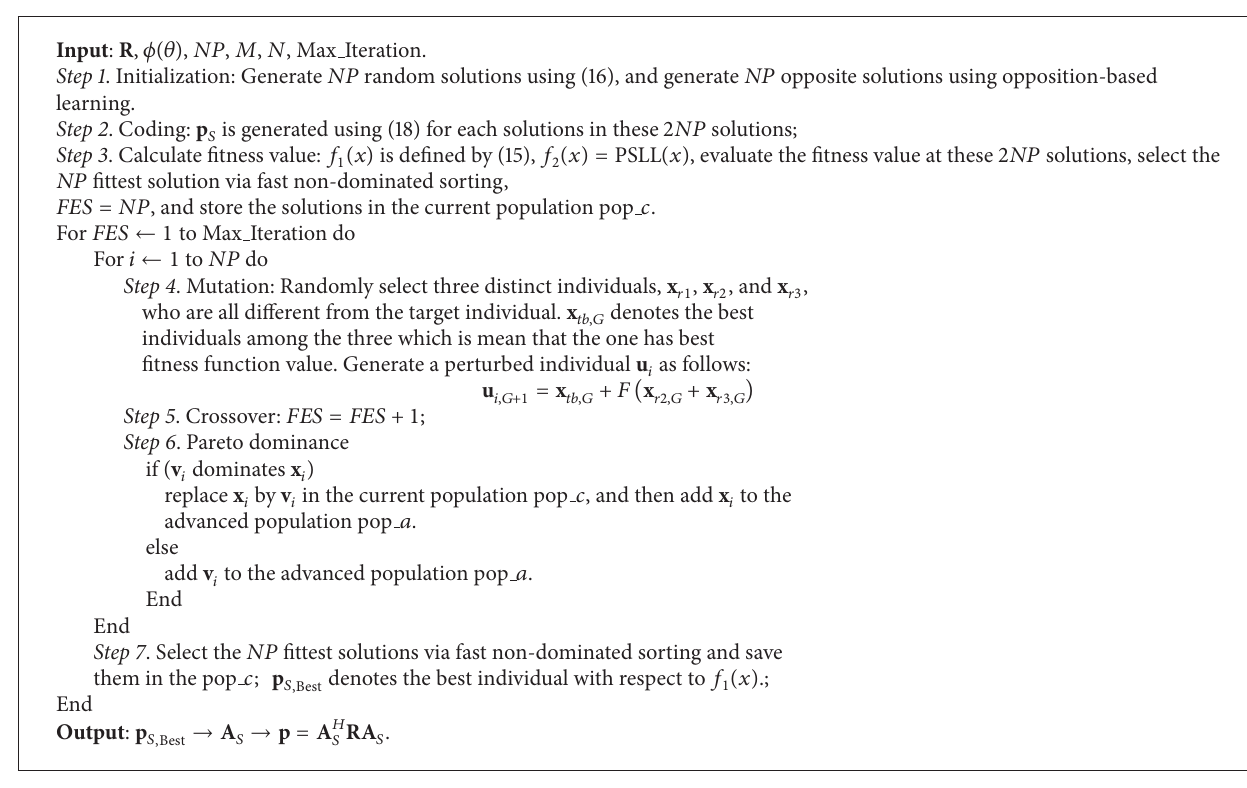
Algorithm 2: Sparse antenna array design using